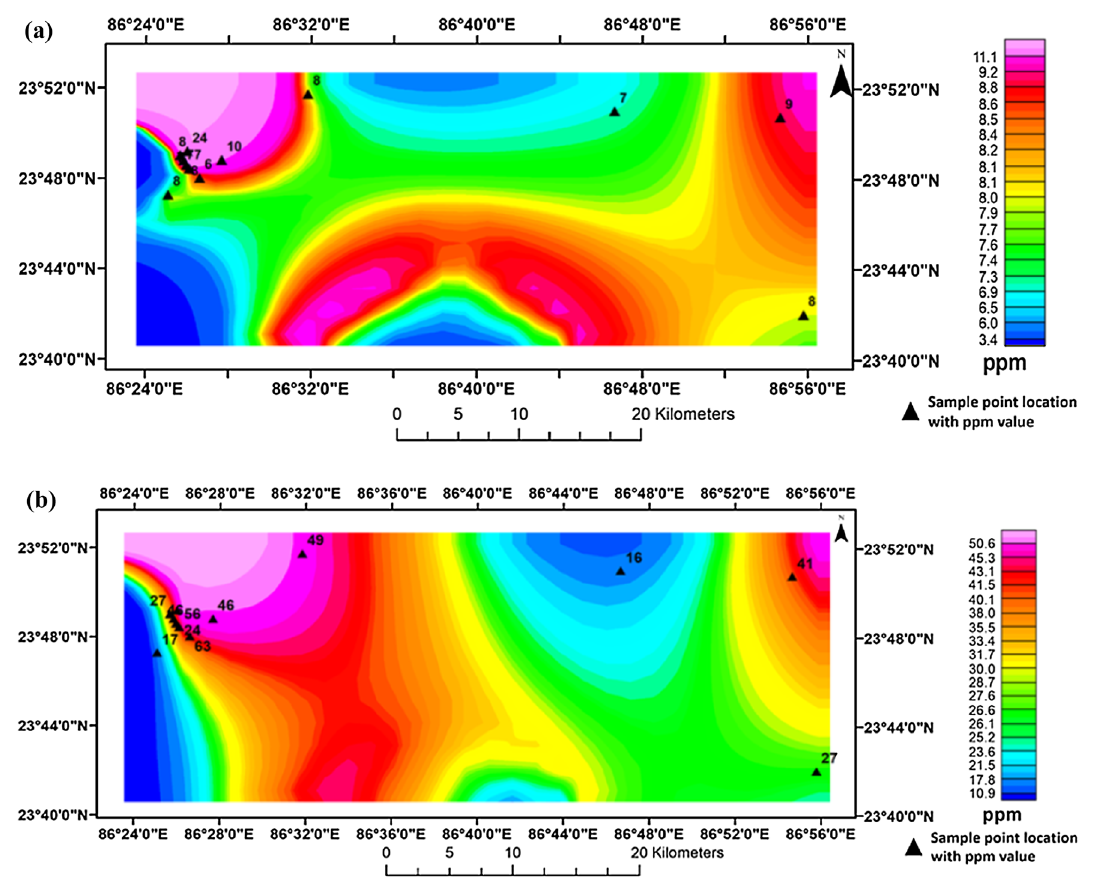
Na + ) in the pond, surface water b Spatial distribution of sodium ions ( and underground water bodies in ppm, in and around the Dhanbad district of Jharkhand represented by contour